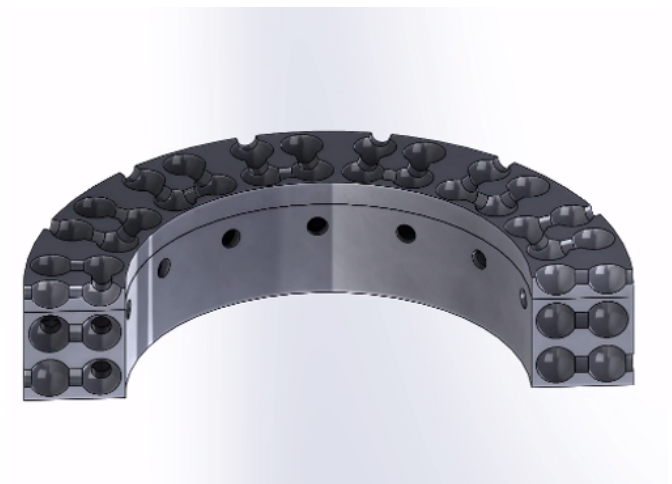
Figure 8. Slice through DENORMS